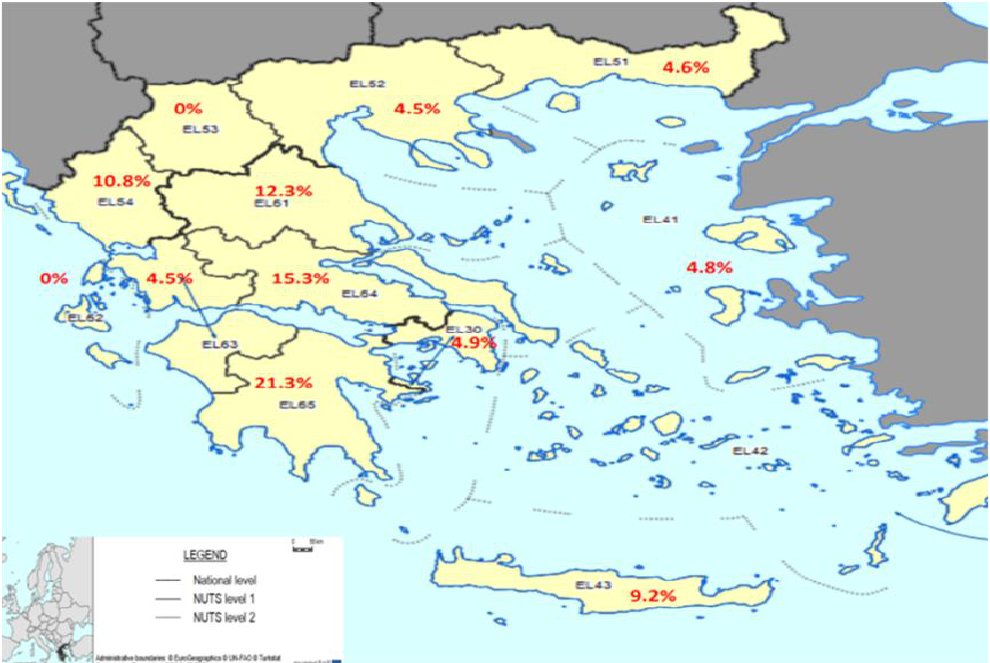
Figure 4. Total seroprevalence of pertussis (positive and borderline) by regions (Eurostat Nuts